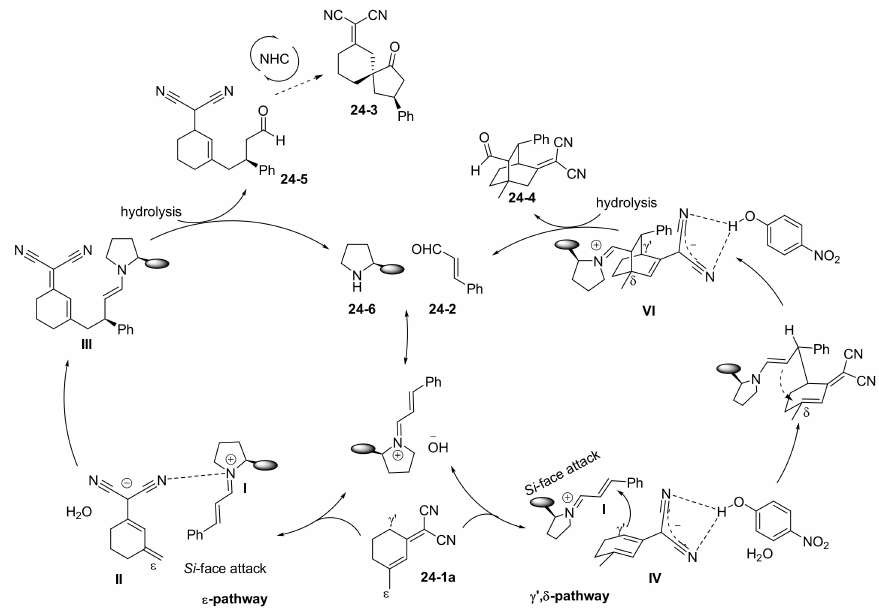
Scheme 48. Proposed reaction mechanism for regiodivergent ε - and γ ’, δ